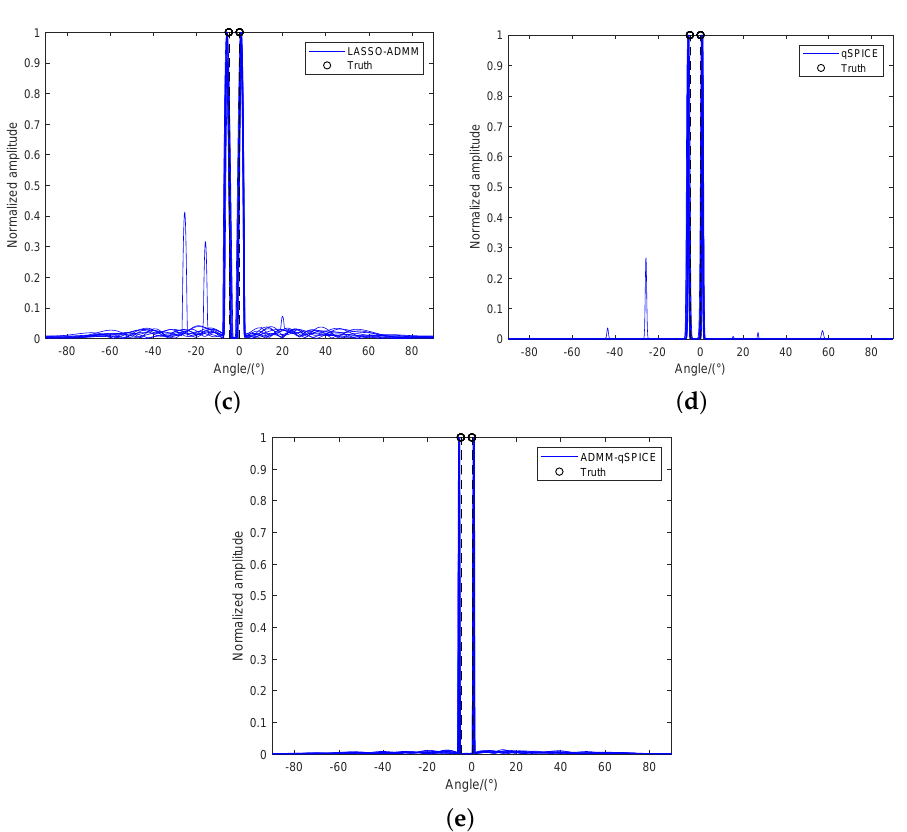
Figure 1. Simulated DOA results. ( a ) DAS method, ( b ) IAA method, ( c ) ADMM − LASSO method ( λ = 1 and ρ = 10), ( d ) qSPICE method, and ( e ) proposed method ( ρ = 1.2).